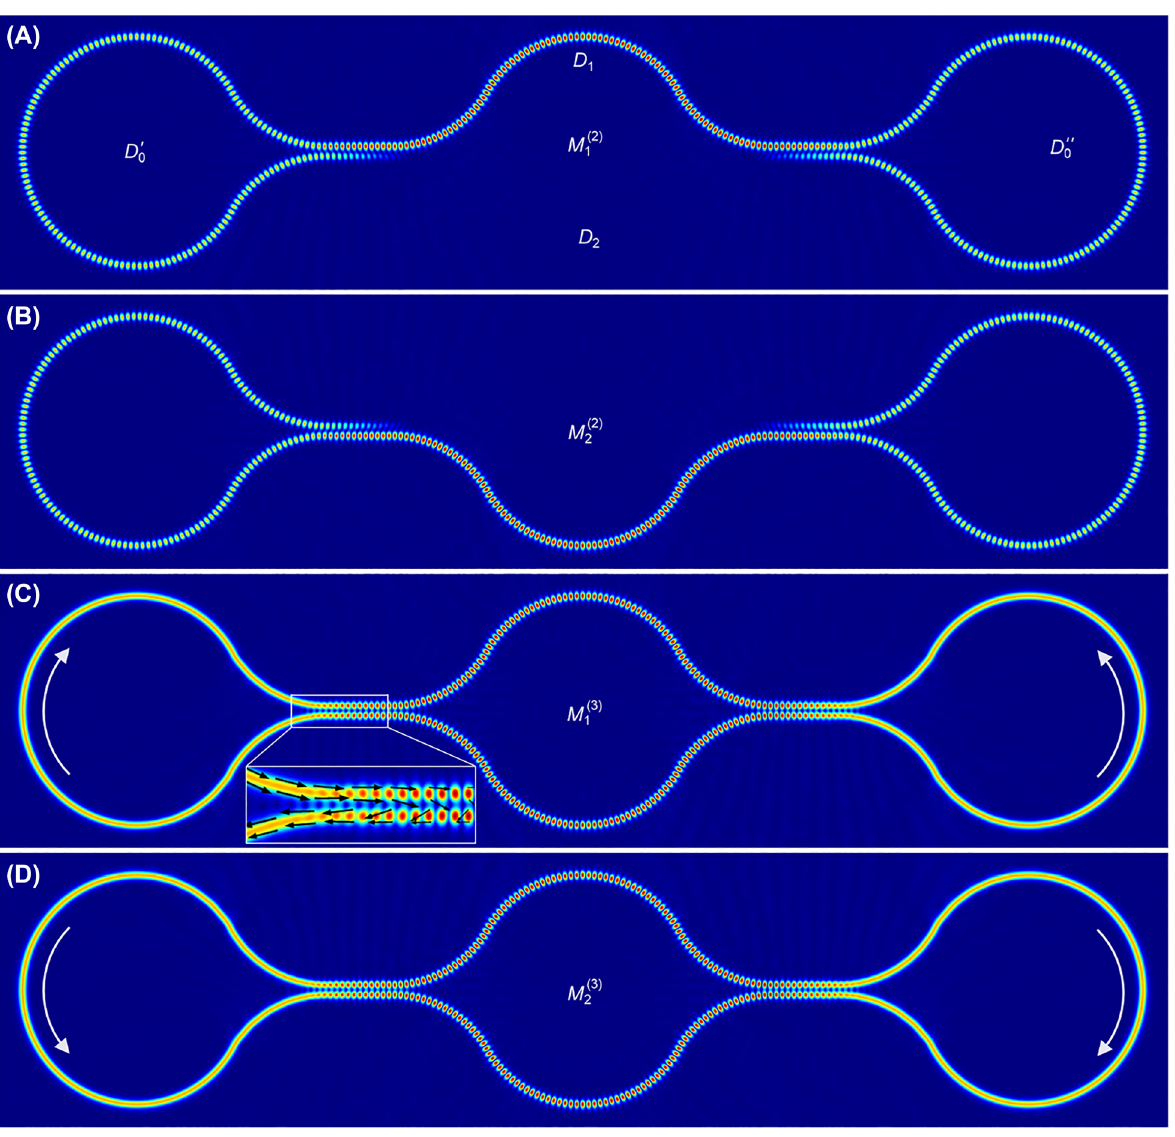
Figure 3: Eigenmodes of the hybrid-wave resonator presented in Figure 2. (A) and (B) are plots of electric field component perpendicular to | ) associated with the two degenerate standing-wave modes M (2) the resonator’s plane ( | E z = D ′ ∪ D ′′ . These correspond to basis B respectively, where D 0 0 0 = M (2) + M (2) = M (2) − M (2) and M (3) , which feature a hybrid standing- and traveling-wave character. The white arrows in (C) and (D) M (3) 1 1 1 2 2 2 indicate the traveling direction of traveling wave. The Poynting vectors (black arrows in inset of (C)) circulate around the loop in domain D and vanish in domain D . The details of the geometry and material parameters used in these simulations are presented in 1 , 2 Supplementary Materials